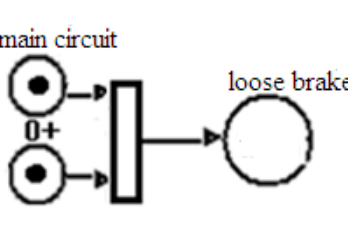
Figure 5. Before